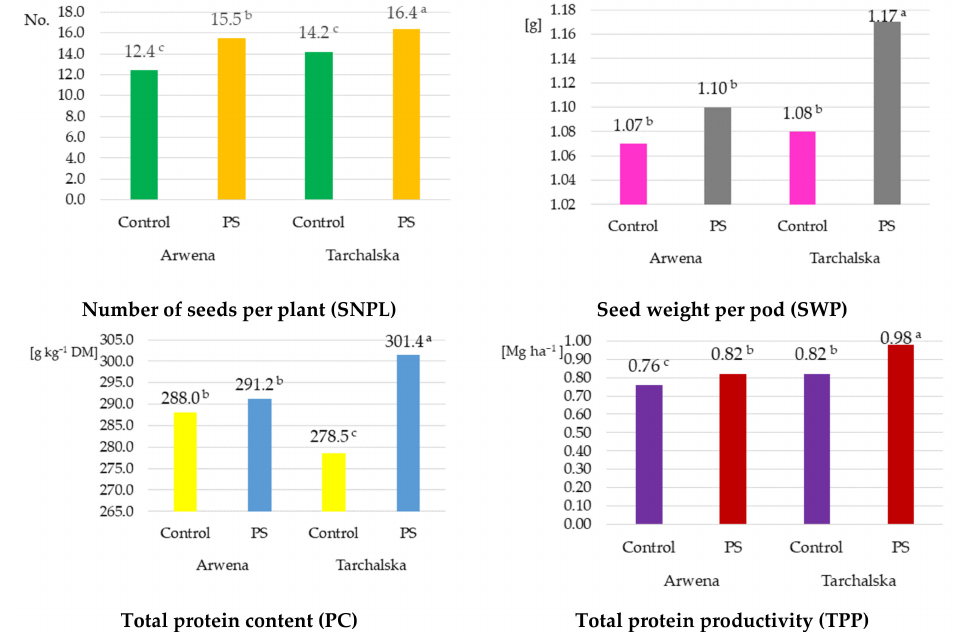
Figure 2. Significant effect of C × A interaction on analysed parameters in 2019. PS—pod sealant application. Different letters indicate a significant difference at p < 0.05 (Tukey’s multiple range